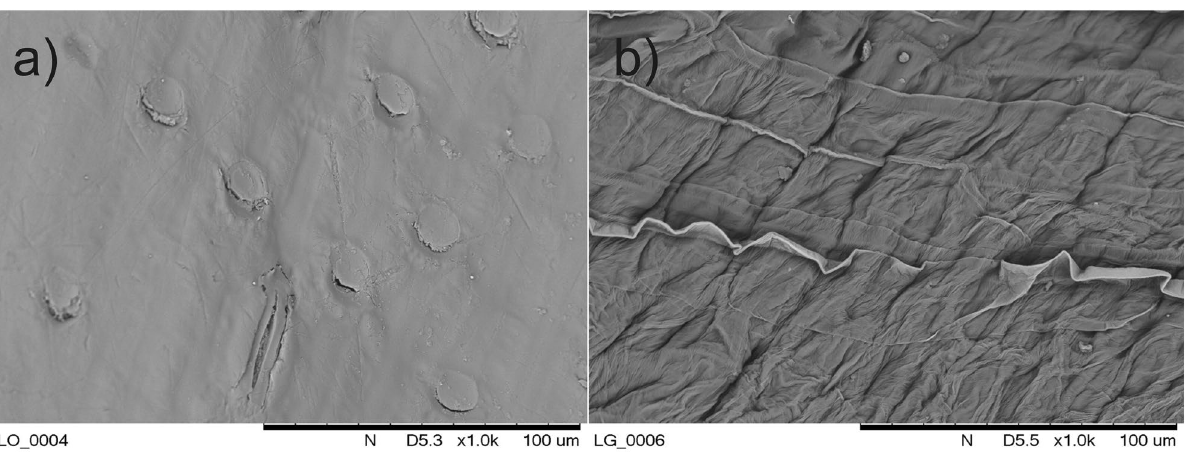
Figure 4. Surface structure of spelt grains ( a ) and bran ( b